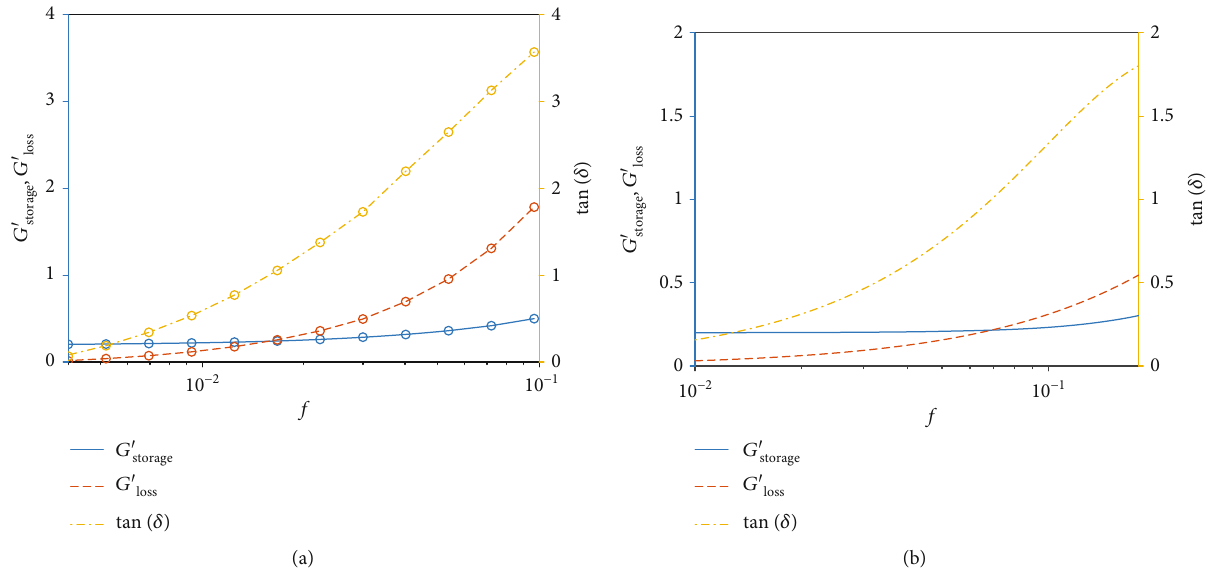
Figure 12: In fl uence of frequency, f ( x -axis), on complex moduli ( y -axis); G ′ tangent factor); (a) complex moduli ( y -axis) established by the PCD equation at conditions j (cid:1) ρ ( y -axis) established by the SLS model at conditions σ